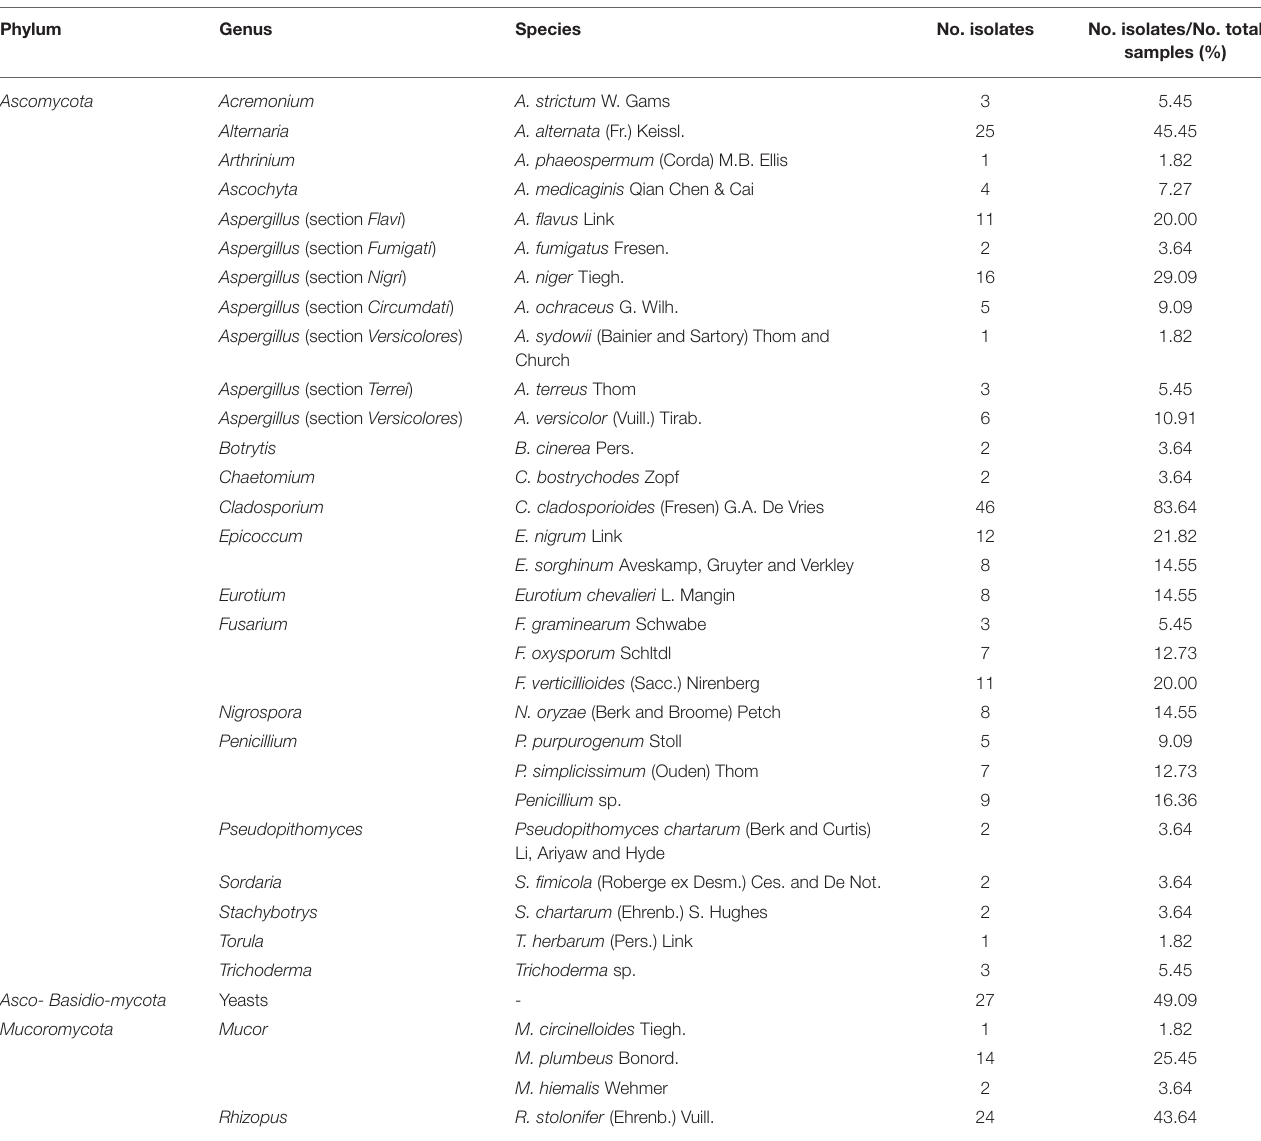
TABLE 2 | Mycological results of hay samples. Phylum